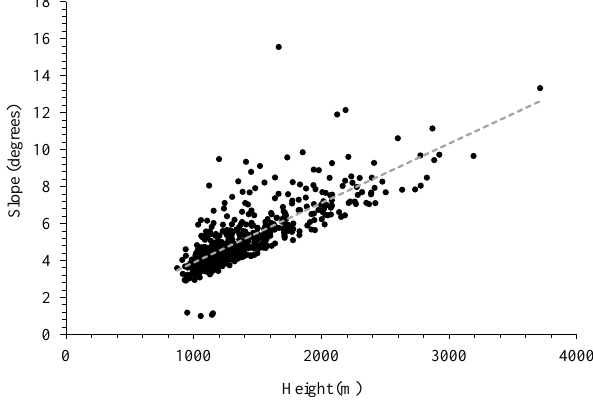
Fig. 7. Relationship between seamounts slope angle ( ϕ) and seamount height ( h) in the OSPAR area. The relationship can be expressed as ϕ = 0 . 003 h + 0 . 65; r 2 = 0 .